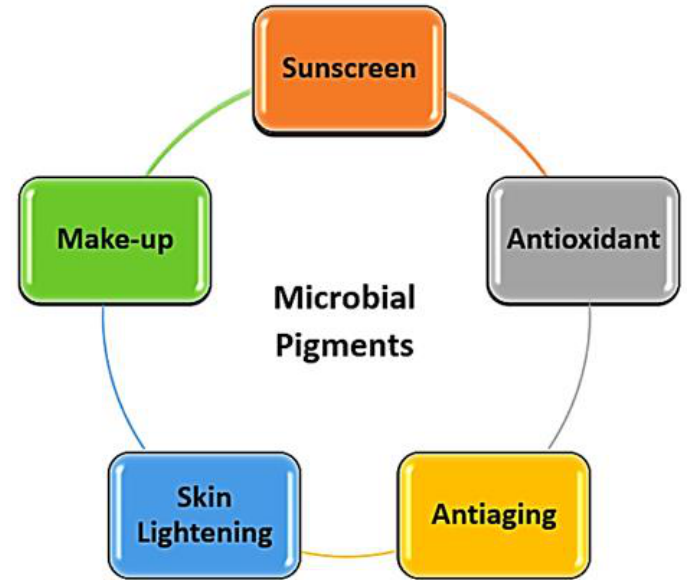
Figure 1. Application of microbial pigments in cosmetic products.